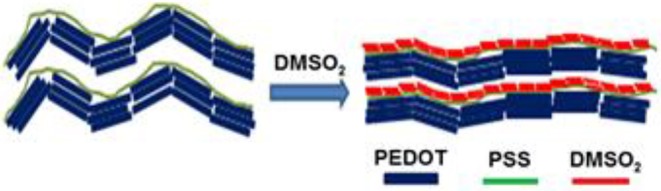
The cartoon process for the interaction between DMSO2 and PEDOT:PSS.